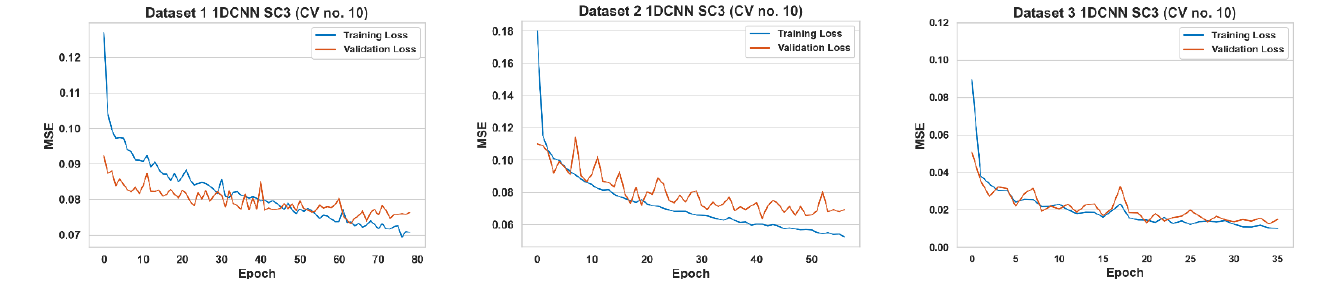
9 of 20 Table 3. List of hyperparameters that were tuned for each ML-based algorithm. Algorithm List of Hyperparameters RFR